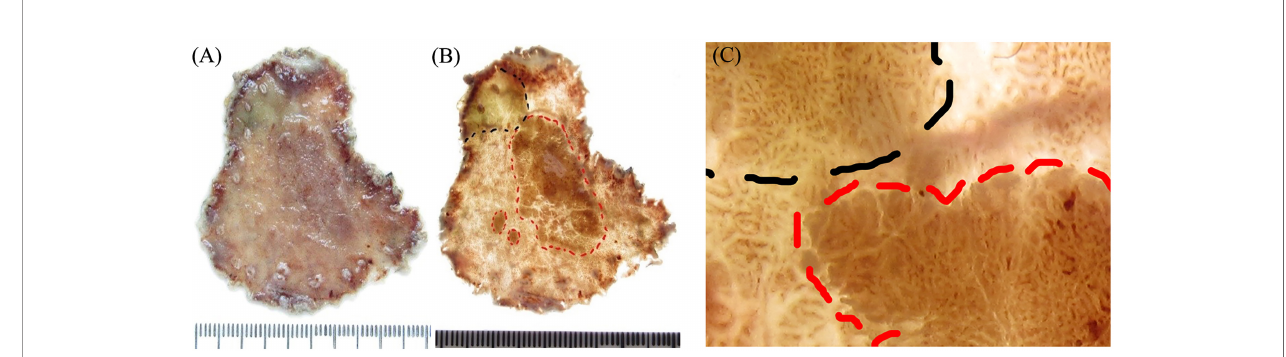
FIGURE 4 | Comparison of the macroscopic specimen images between the conventional and light transmission-assisted pathological examinations. (A) The conventional pathological examination of the endoscopic submucosal dissection (ESD) specimen reveals a single super fi cial elevation of the mucosal surface with a slight depression in the center. (B) The light transmission-assisted pathological examination shows three distinct regions in the same ESD specimen according to the color and texture of the mucosal surface under the light-emitting diode (LED) light. (C) Close examination under the LED light reveals the dense mucosal microstructure and irregular microvessels of the lesion and distinguishes them from